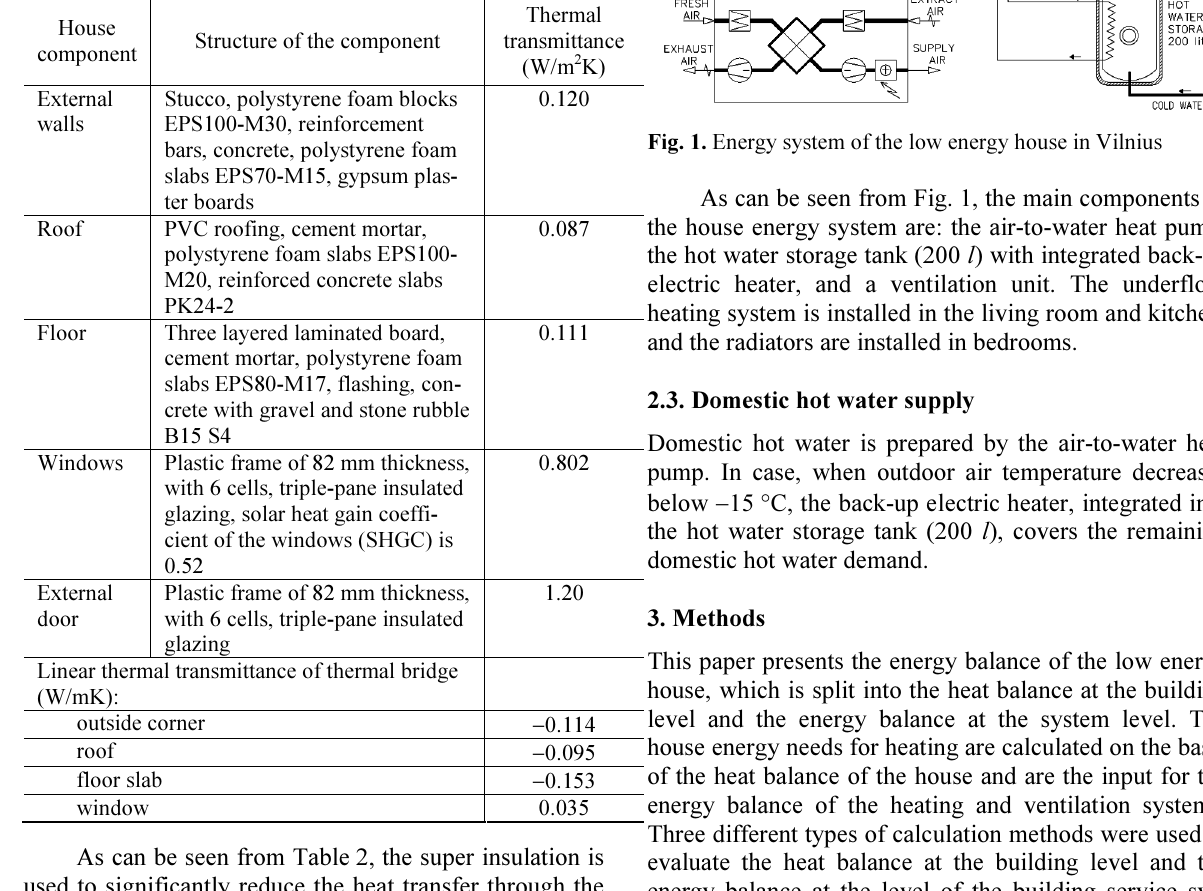
Table 2. The thermal transmittance of house elements